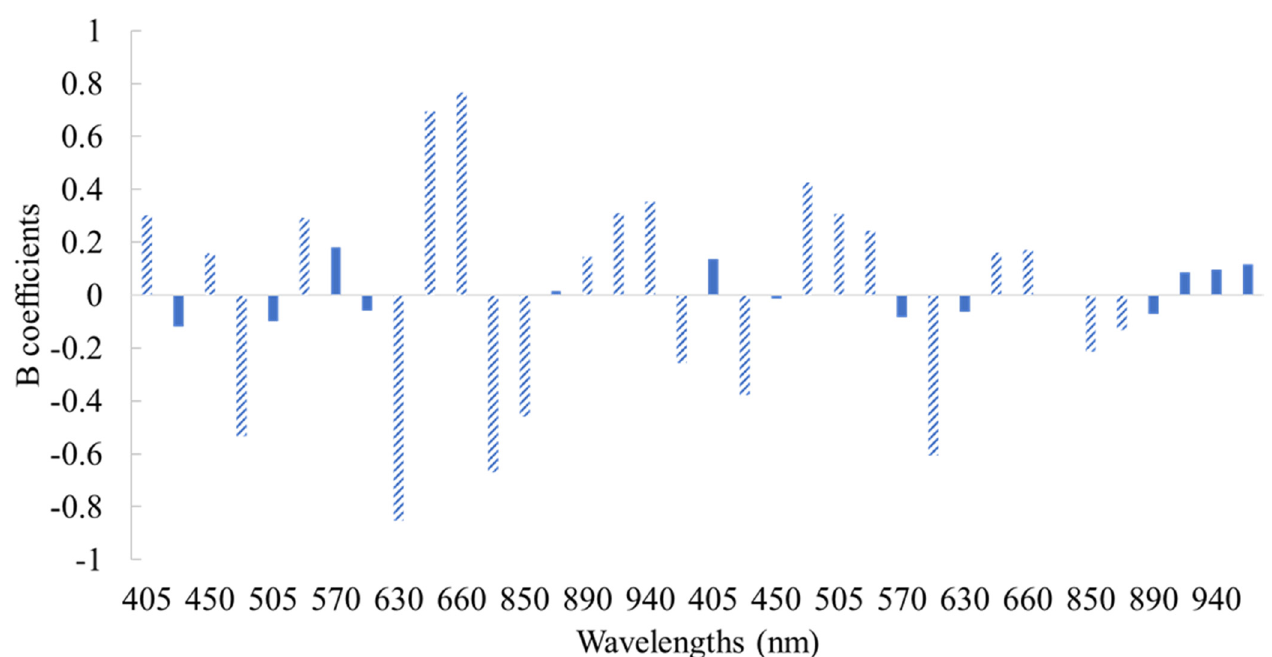
Figure 5. Beta (B) coefficient values of the PLS-R model developed on MSI spectral data for chicken thigh fillets. Shaded bars indicate important variables (mean intensity and standard deviation of pixels from each wavelength).